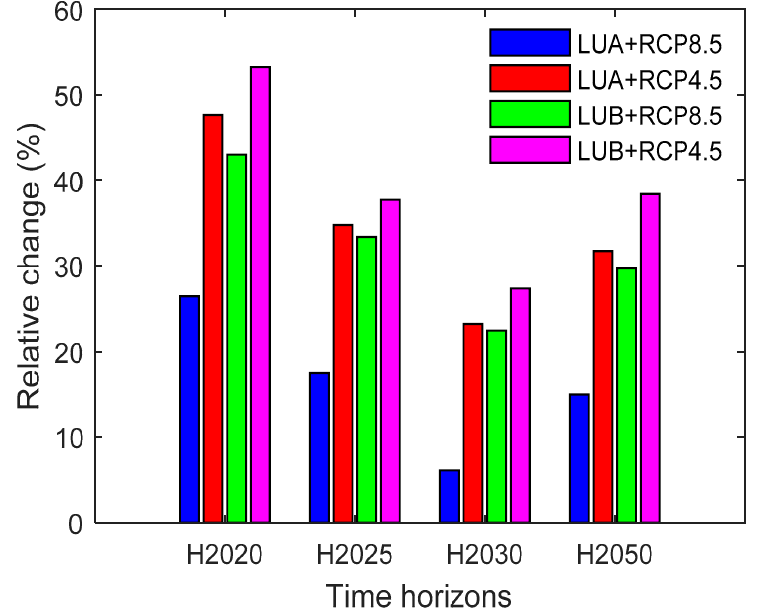
Figure 10. Time horizon annual total runoff relative change for different time horizons and following different climate and land use combined scenarios.